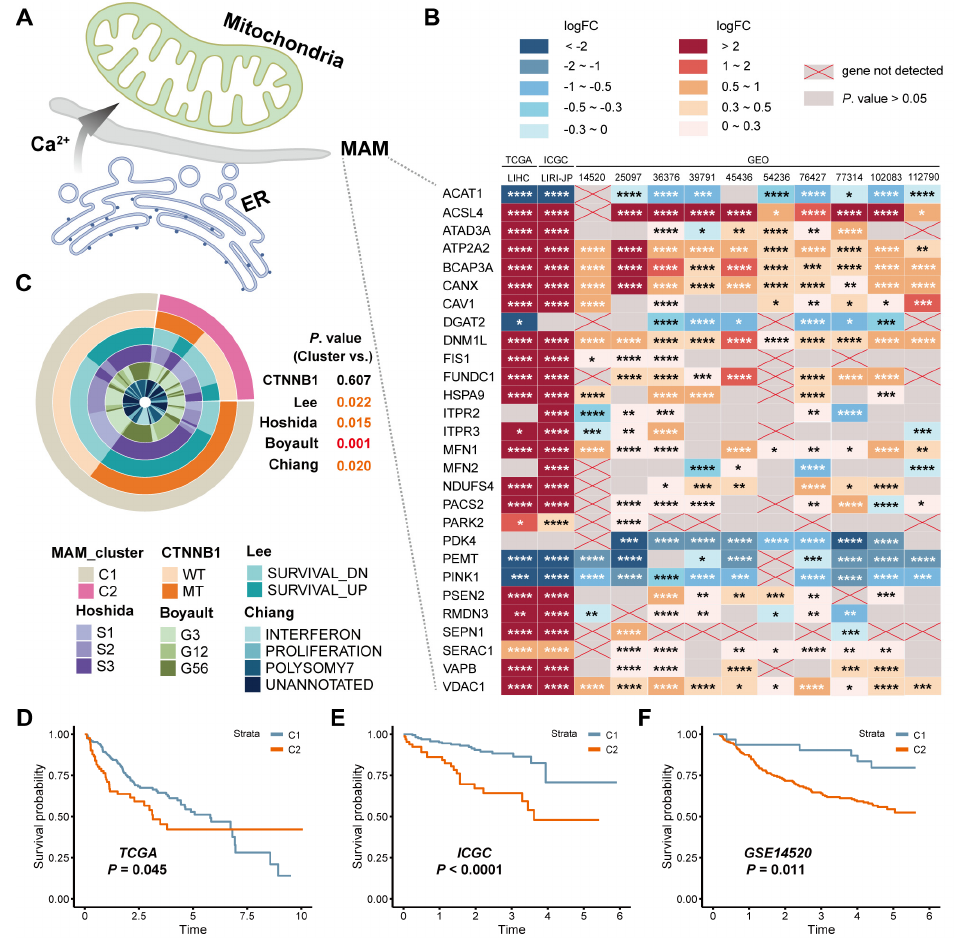
Figure 2. Identification of the expression and prognostic value of MAM in HCC. ( A ): Illustration of the MAM structure. ( B ): Heatmap of the expression of MAM-related genes in several HCC datasets. ( C ): Correlations between the generated cluster and other HCC subtypes. ( D – F ): KM curves of different MAM-related clusters in the TCGA, ICGC, and GSE14520 datasets. * p < 0.05; ** p ≤ 0.01; *** p ≤ 0.001; and **** p ≤ 0.0001.